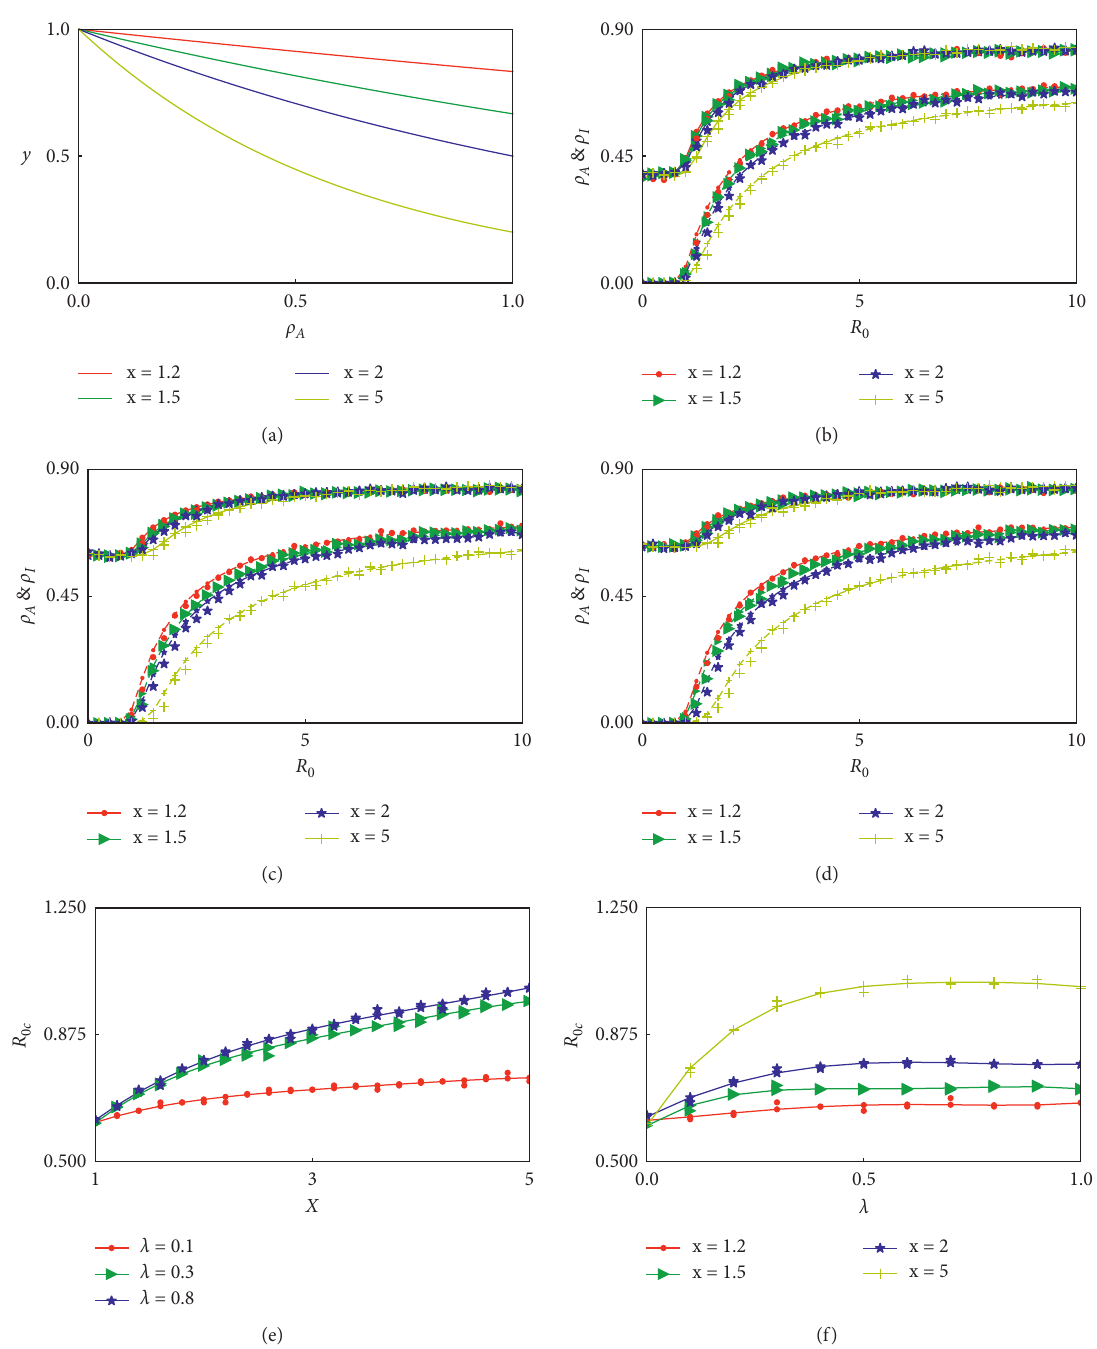
Figure 5: (a) Plots of the function c � x − ρ A for different x values. The dependence of prevalence ρ shown in (b) for λ � 0 . 1, (c) for λ � 0 . 3, and (d) for λ � 0 . 8. Solid lines represent the ratio of awareness nodes ρ A and dashed lines represent the ratio of infected nodes. Symbols represent the simulation results and different colors correspond to different x values. (e) Dependence of the critical infection rate R for the epidemic outbreak on parameter x . (f) Dependence of R 0 c